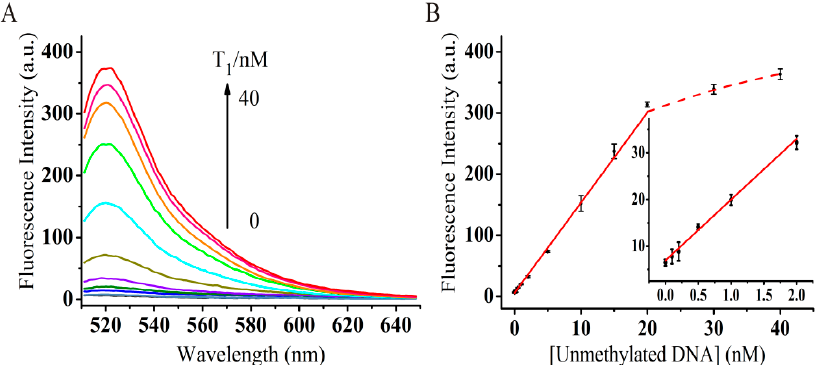
Figure 4. ( A ) Fluorescence spectra of the hybridization of 20 nM probe DNA with various concentrations of T 1 (0, 0.1, 0.2, 0.5, 1, 2, 5, 10, 15, 20, 30 and 40 nM); ( B ) The linear relationship of F (Y) with various DNA concentrations (X) ranging from 0 to 40 nM. The inset shows linear responses to low concentrations of T 1 ranging from 0 to 2 nM. Error bars represent the standard deviation of three experiments.